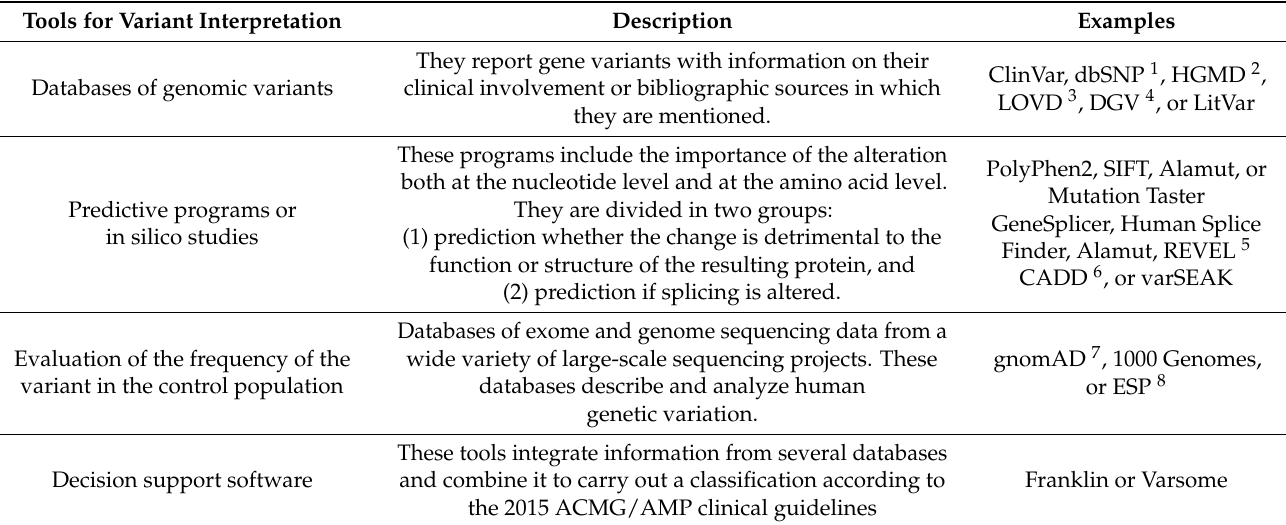
Table 1. Main tools for variant